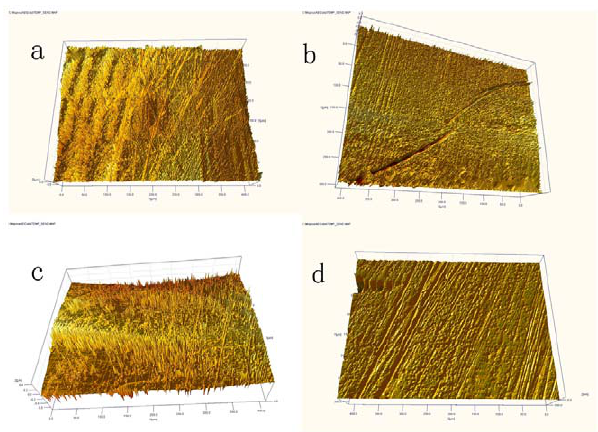
Figure 7. 3D profile micrographs from the center of the wear zone of the femoral head (a) and cup (c) in control group after 3MC wear test. More protein deposition, shallow grooves, less wear. 3D profile micrographs from the wear zone of the femoral head (b) and cup (d) in experimental group after 3MC wear test. Less protein deposition, deeper grooves, more wear.